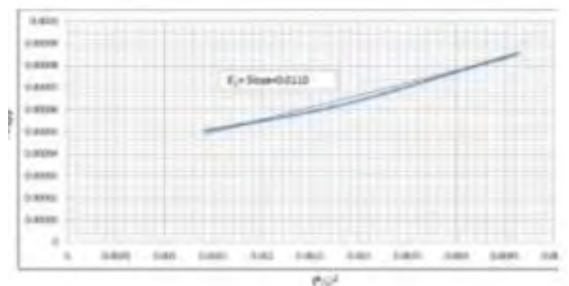
Figure 39. The slope of K1 (Author’s own,